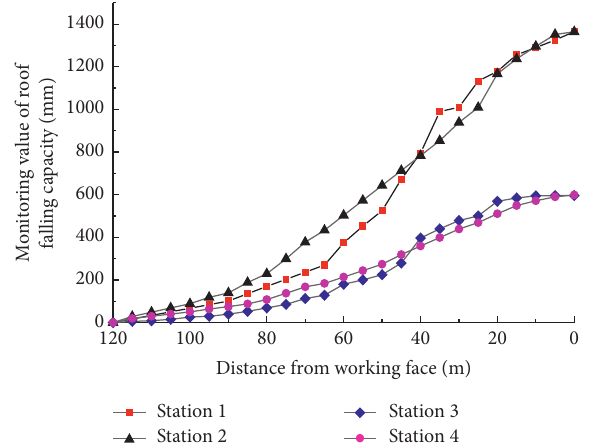
Figure 11: Curve diagram of roof falling capacity of each station.